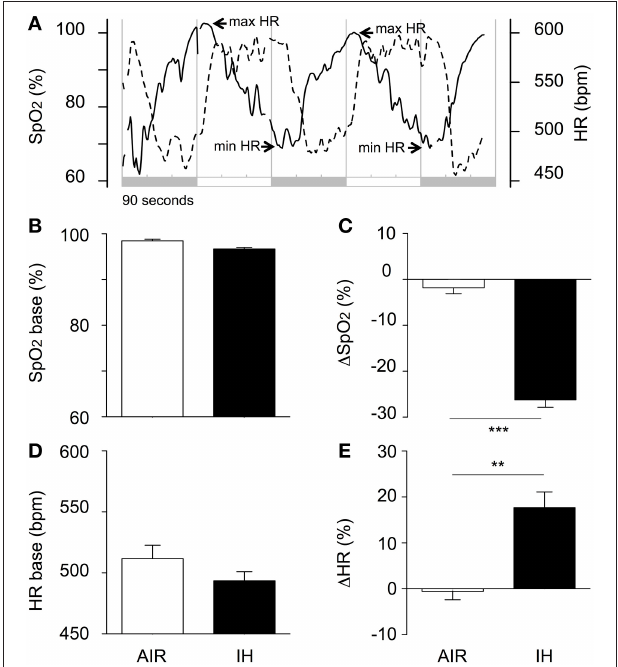
FIGURE 2 | Acute changes in oxyhaemoglobin saturation (SpO 2 ), and heart rate (HR) during IH or air exposure. (A) Illustrative individual traces of SpO 2 (dotted line) and HR (solid line) in a pup from the IH group. The shaded areas indicate 90-s hypoxic stimuli alternating with 90-s air exposures. (B) Baseline SpO 2 values; (C) Hypoxia was associated with a marked decrease in SpO 2 ; (D) Minimal HR values were used as estimates of baseline values. The difference between the IH and AIR groups was not significant ( p = 0.181 ); (E) Hypoxia was associated with a moderate increase in HR. The minimal and maximal SpO 2 values were calculated as the mean values over the last 30s of hypoxia and air, respectively. The minimal and maximal HR values were calculated as the mean value over the 30-s period following each switch from air to hypoxia and from hypoxia to air, respectively. The percentage responses to hypoxia of SpO 2 ( 1 SpO 2 , C ) and HR (DHR, E ) were calculated as 100 · (min SpO 2 -max SpO 2 )/max SpO 2 and 100 · (max HR-min HR)/min HR, respectively. SpO 2 and HR data were pooled over days and sessions, from P6 to P10, as these factors had no significant effect on either variable. Values are group means ± SEM. *** p < 0.001 , ** p < 0.01 .